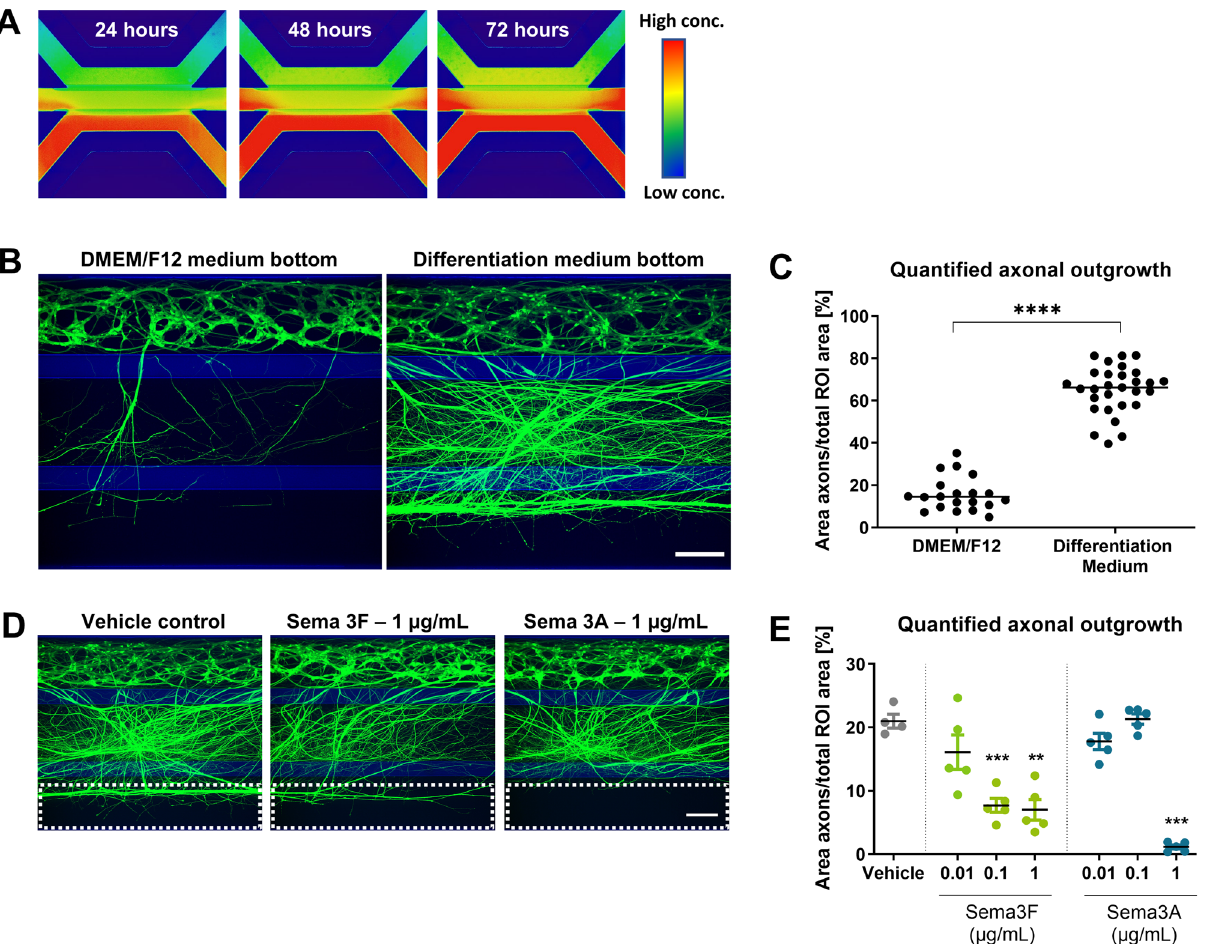
Figure 6. Attraction and repulsion of axons. ( A ) Gradient formation is visualized by perfusion of a fluorescein isocyanate (FITC)-Dextran (150 kDa) molecule through the bottom lane of a tissue culture chip. Images were taken at 24 h, 48 h, and 72 h after perfusion, showing stable gradient formation in the OrganoPlate. ( B ) Motor neurons (day 17) were cultured with either DMEM/F12 or motor neuron differentiation medium in the bottom lane to assess axon attraction. Cultures are visualized using calein-AM dye. Maximum projection images, the scale bar is 200 µm. ( C ) Quantification of axon outgrowth shown in ( B ) shows a significant (P < 0.0001) increase in outgrowth upon perfusion of the bottom lane with motor neuron differentiation medium. Graph shows mean ± SEM, n = 20–29, N = 2; unpaired t test. ( D ) Motor neurons (day 17) were cultured with either semaphorin 3F (SEMA3F) or 3A (SEMA3A) in the bottom lane to assess axon repulsion. Cultures are visualized using calein-AM dye. Maximum projection images, the scale bar is 200 µm. Dashed lines indicate the region of interest for axon outgrowth quantification in ( E ). ( E ) Quantification of the axon outgrowth depicted in ( D ). Axons were significantly less prevalent in the bottom microfluidic lane when perfused with SEMA3F (1 µg/mL, P = 0.001; 0.1 µg/mL, P = 0.0003) or SEMA3A (1 µg/mL, P = 0.001). Graph shows mean ± SEM, n = 5, *(P < 0.05), ** (P < 0.01), or *** (P < 0.001); Brown-Forsythe and Welch test. The graphic representations in ( B ) and ( D ) were created using GraphPad Prism, version 8.3.1 (https ://www.graph pad.com/scien tific -softw are/prism